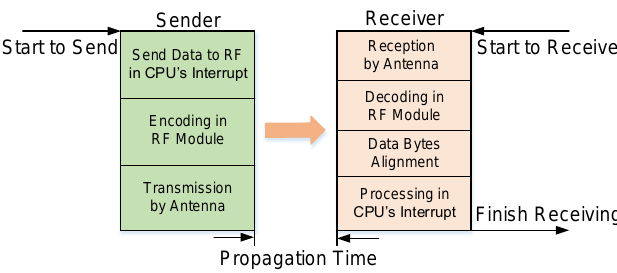
Figure 5. The process of the transmission for the time synchronization signal (TSS). RF: radio frequency.